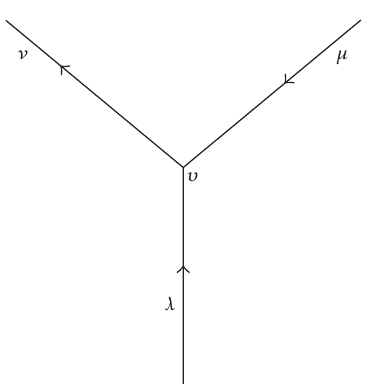
Figure 5: Partition triple at a vertex (cid:8)λ v : (cid:5) (cid:6) λ (cid:3) ,μ (cid:3) ,ν (cid:7)